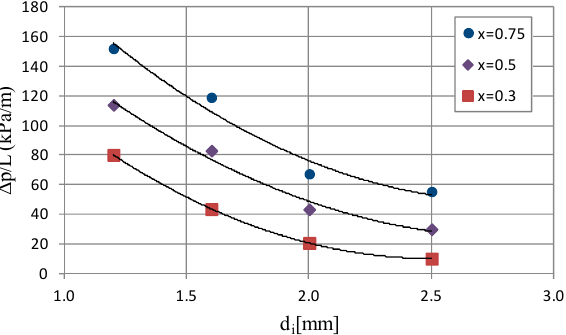
Figure 9. Dependence of pressure drops on internal diameter of minichannel ( ∆ p/L) = f(d i ) for G ≈ 519 kg/m 2 s and inlet T s = 39 °C.